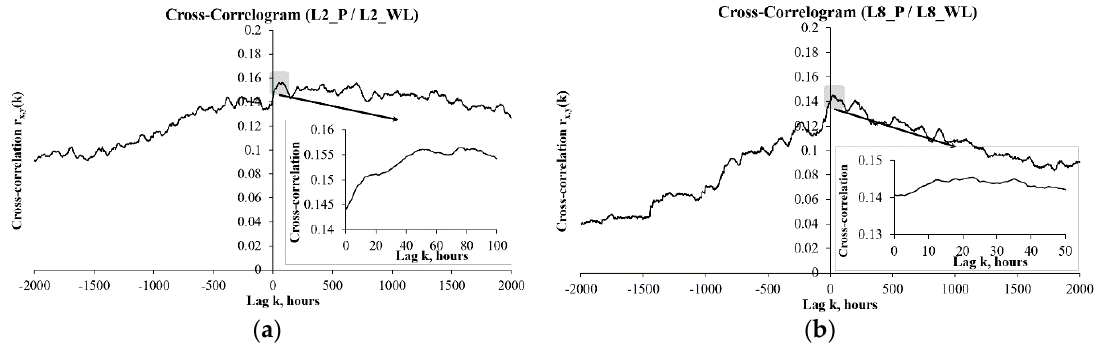
Figure 17. ( a ) Cross-correlogram between the L2_P and L2_WL data; ( b ) cross-correlogram between the L8_P and L8_WL data.